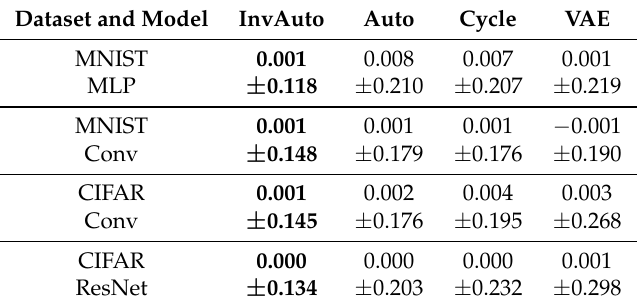
Table 1. Mean and standard deviation of cosine similarity of rows of E . InvAuto achieves cosine similarity that is the closest to 0. Best performer is in bold.